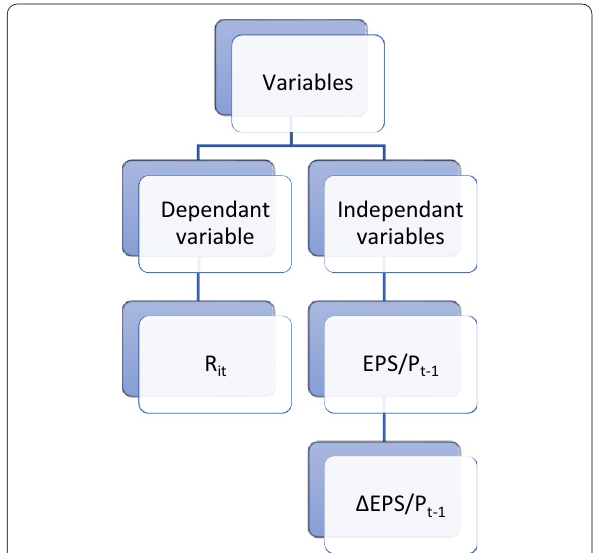
Fig. 1 The main research